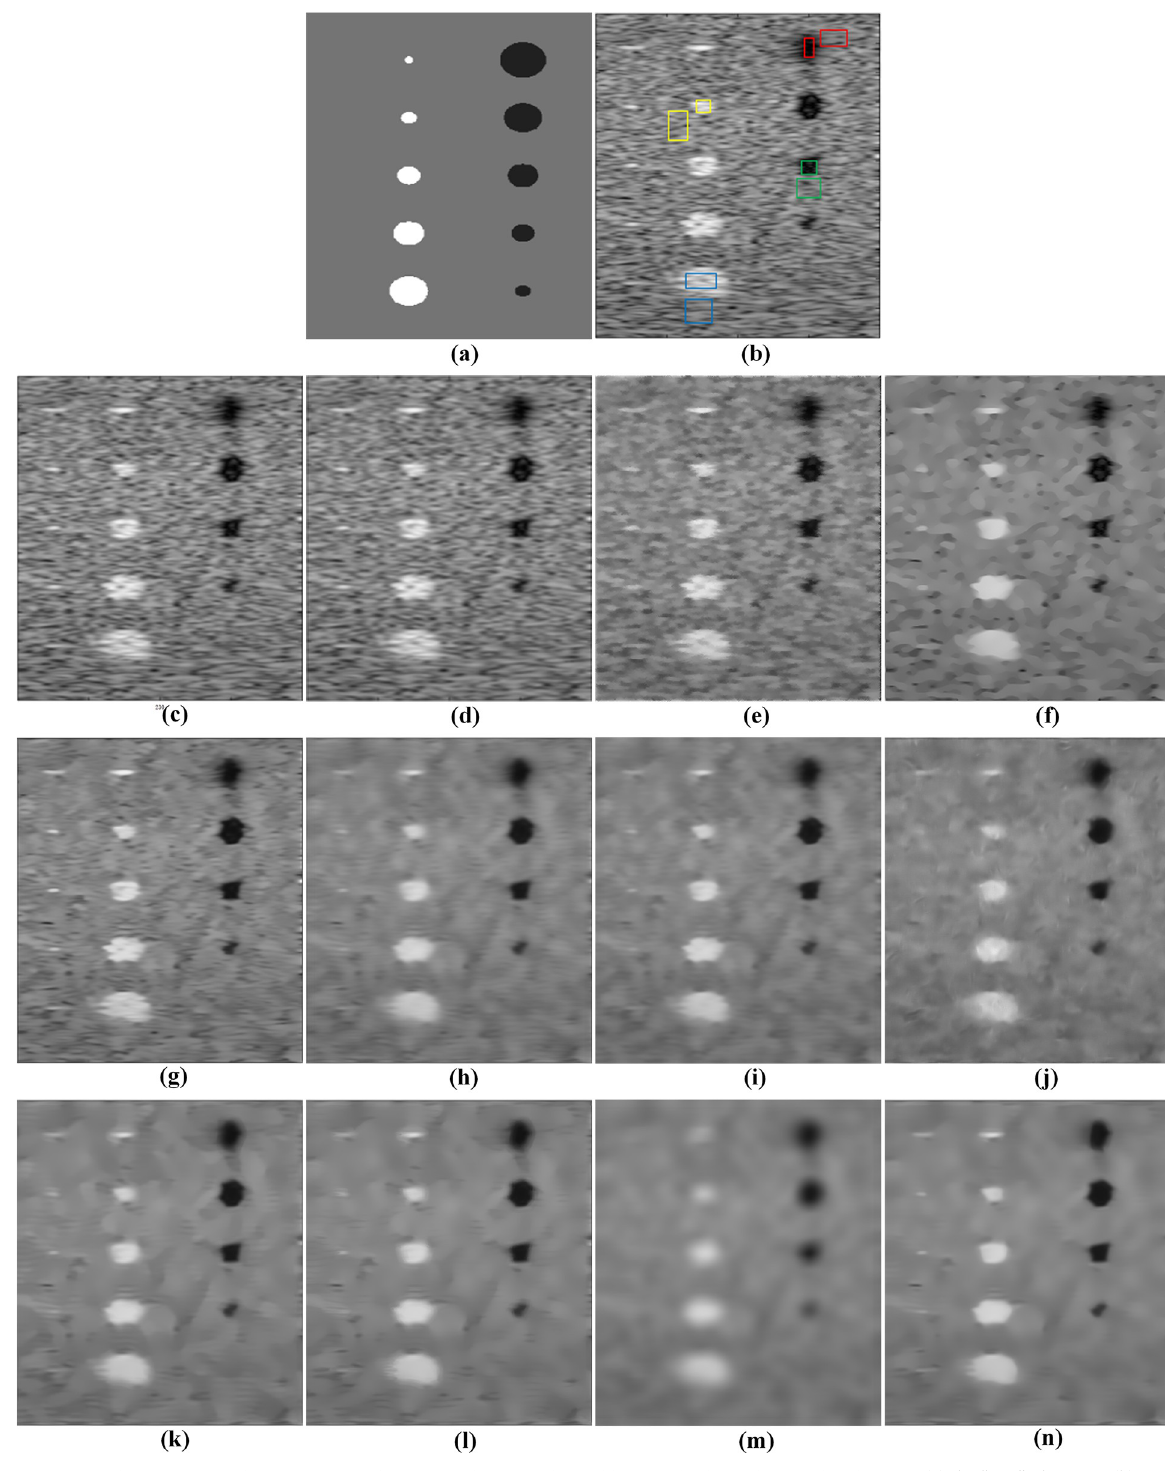
Fig 7. Visual comparison of restoration performance of various despeckling methods on the simulated image. (a) the “cyst” phantom, (b) simulated image generated by Field Ⅱ and four ROIs marked with various colors, (c) Frost filter, (d) Kuan filter, (e) SBF filter, (f) SRAD filter, (g) TNLM filter, (h) OBNLM filter, (i) NLMLS filter, (j) DnCNN filter, (k) OPCA-NLM filter, (l) RPCA-NLM filter, (m) SPCA-NLM filter, and (n) PPCA-NLM filter.